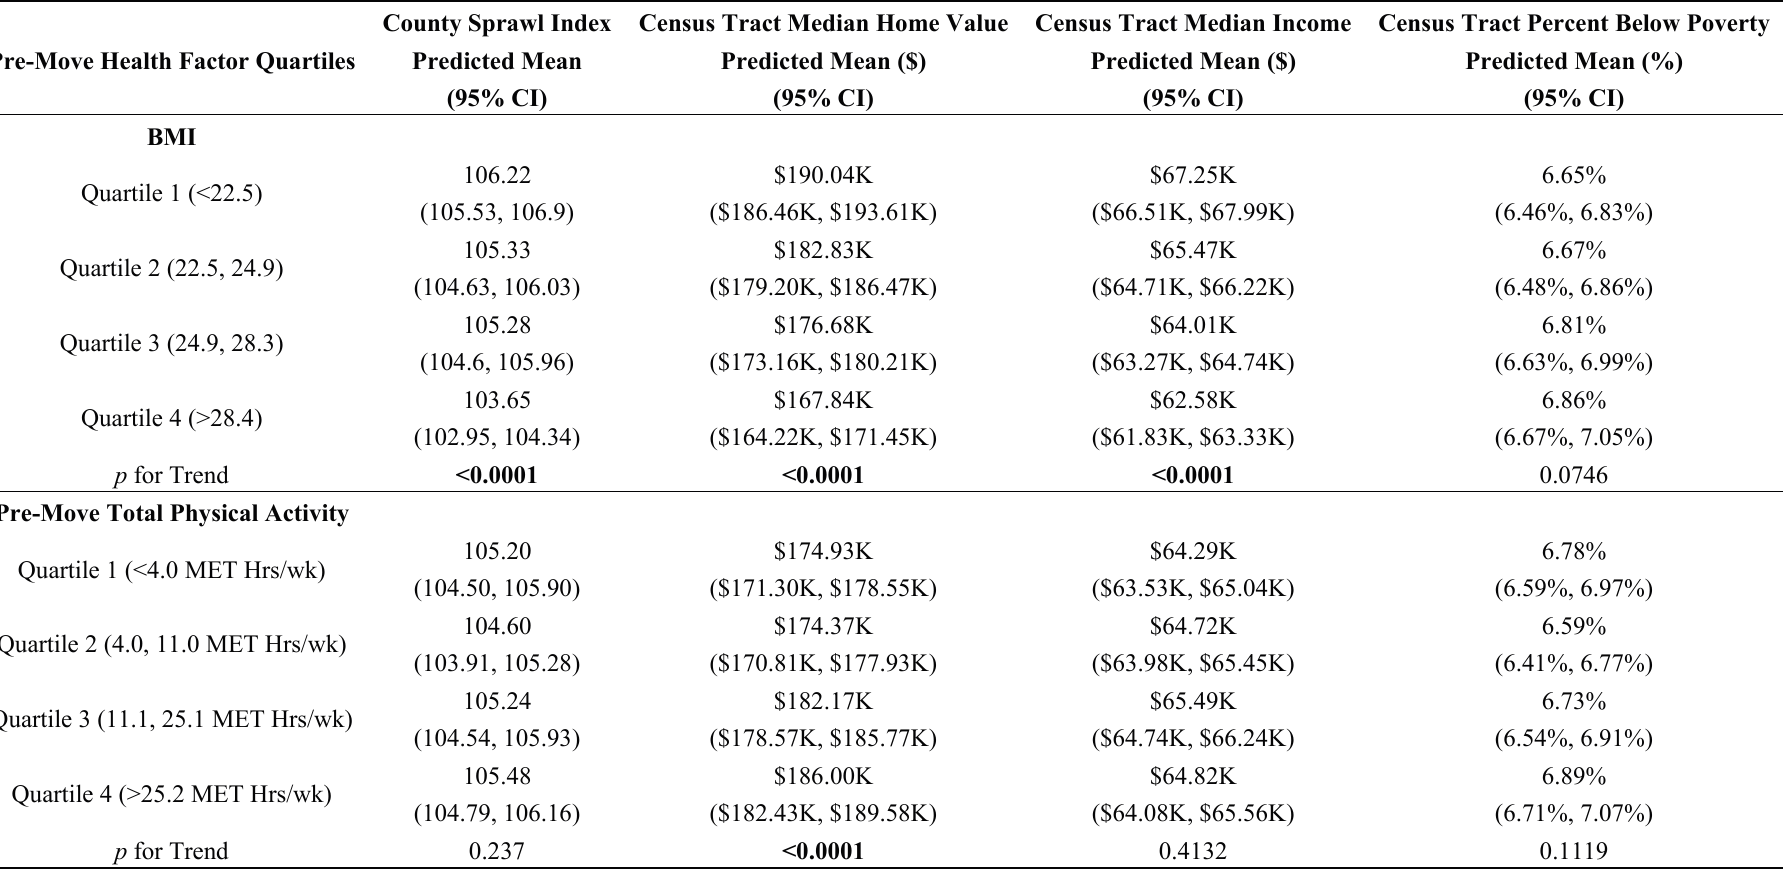
Table 2. Age-adjusted predicted means of neighborhood environment based on pre-move health factors in nurses’ health study participants (n = 14,159 participants) a